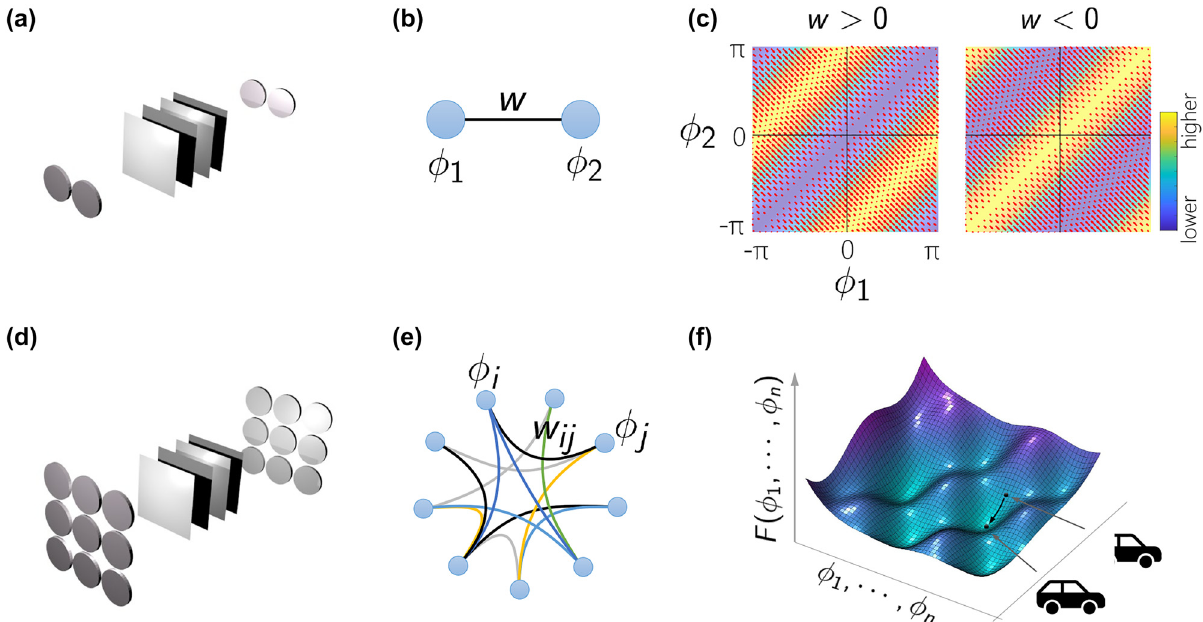
Figure 1: Neural computing with coherenet laser networks. (a) A schematic of two lasers coupled through diffraction engineering. (b) Under proper conditions, the coupled lasers can be represented with their equilibrium phase degrees of freedom, interacting with the coupling rate 𝑤 . (c) The associated energy landscape function governing the equilibrium phases of the two lasers. For 𝑤 > 0 (attractive coupling) the energy function is = 𝜙 , while for 𝑤 < 0 (repulsive coupling) the energy function is minimum for 𝜙 minimum at 𝜙 2 1 network (CLN) composed of an array of coupled lasers that can reach an equilibrium frequency-locked state with constant relative phase for each laser. (e) The associated network graph representing an energy-based neural network with pairwise interactions between lasers described through . (f) The governing multivariate energy function. By locating a desired pattern at a local minimum of the energy function, it can be matrix elements 𝑤 ij retrieved when the network is suitably initialized to start from the attractor basin of the embedded fixed